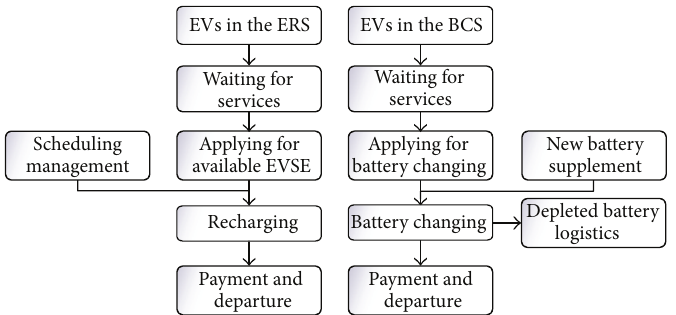
Figure 8: Process of the EV agent in ERS and